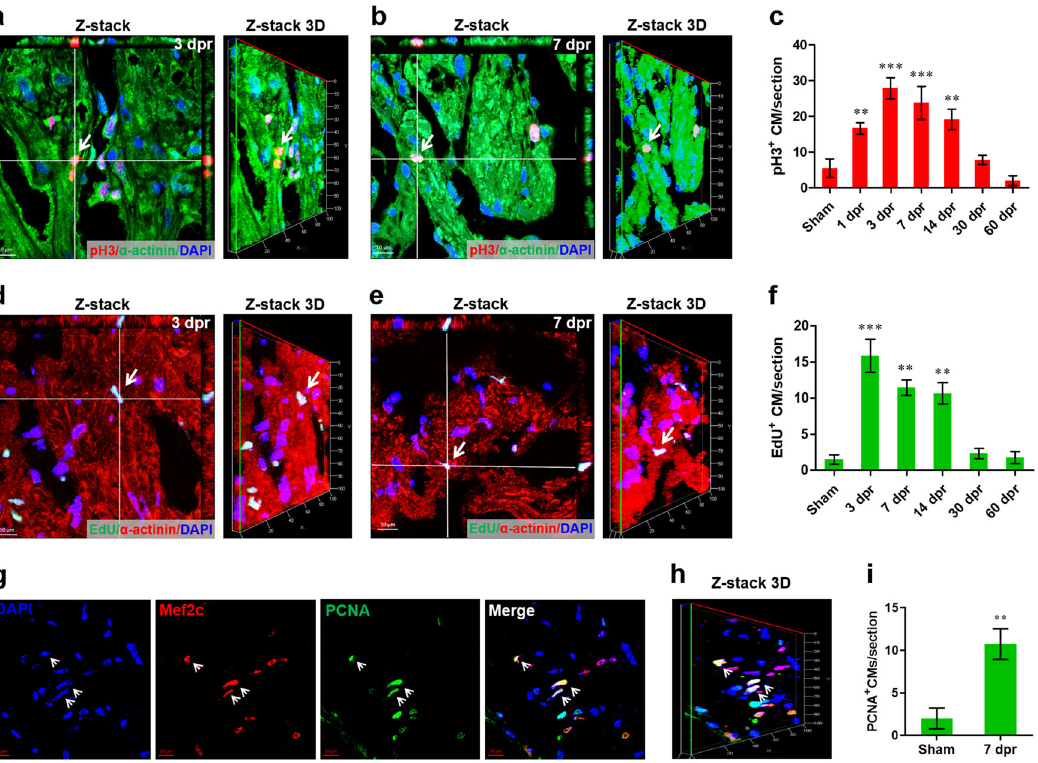
Fig. 2 Surgical injury induces X. tropicalis heart regeneration through cardiomyocyte proliferation. a , b Representative Z -stack confocal images of pH3 + cardiomyocytes (arrow) at 3 ( a ) and 7 ( b ) dpr. c Quanti fi cation of pH3 + cardiomyocytes during heart regeneration within 60 days. Data are presented as mean ± SEM ( n = 4 each), ** p < 0.01, *** p < 0.001 versus sham (one-way ANOVA plus Dunnett ’ s test). d , e Representative Z -stack confocal images of EdU + cardiomyocytes (arrow ) at 3 (d) and 7 ( e ) dpr. f Quanti fi cation of EdU + cardiomyocytes during heart regeneration within 60 days. Data are presented as mean ± SEM ( n = 4 each), ** p < 0.01, *** p < 0.001 versus sham (one-way ANOVA plus Dunnett ’ s test). g – i Representative confocal ( g ) and Z -stack ( h ) images of PCNA + cardiomyocytes (arrow) at 7 dpr with the quanti fi cation ( i ). Data are presented as mean ± SEM ( n = 4 each), ** p < 0.01 versus sham (Student ’ s t